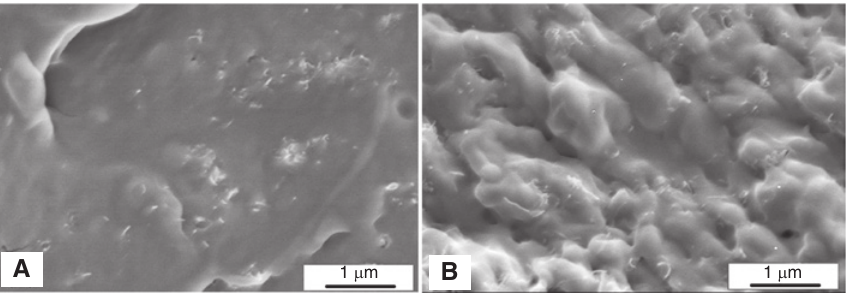
Figure 8: Scanning electron microscopy images of PLA/MWCNT composites with 1wt.% MWCNTs: rolling ratios of (A) 0% and (B) 60% (paral- lel to rolling direction).